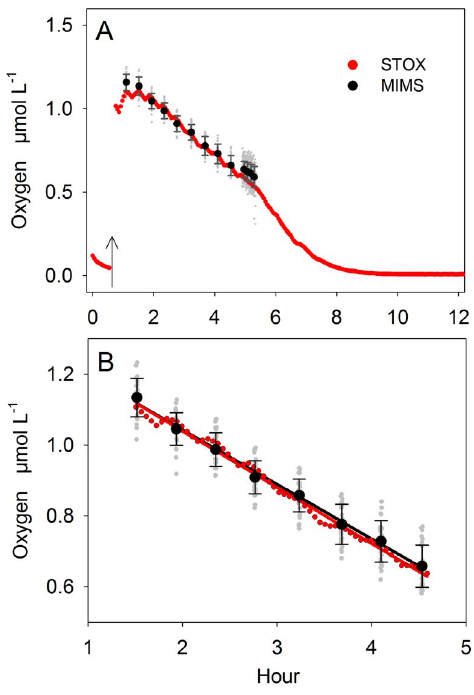
Figure 5. Experiment 2: Comparing MIMS and STOX sensor. O 2 concentration and consumption rates measured after the addition of 1.2 m mol 18-18 O 2 L 2 1 (arrow) (A). Individual MIMS measurements (grey dots) are averaged (black dots) and presented with the respective standard deviation. From the entire experimental run 3 hours of simultaneous measurements (B) were used for rate calculations.